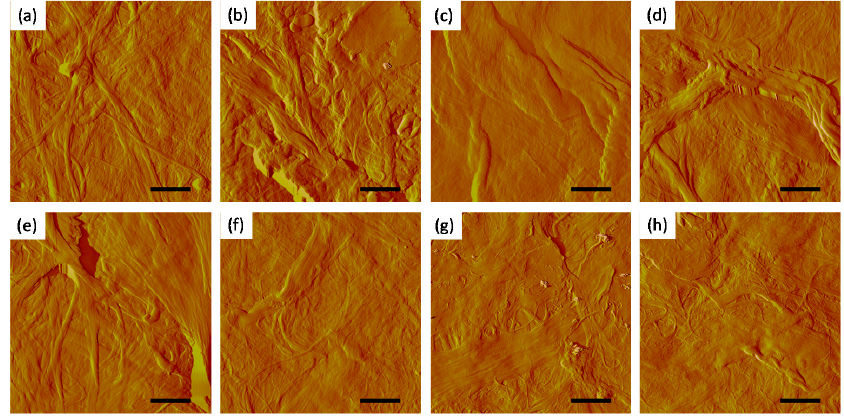
Figure 6. AFM amplitude images (10 × 10 μ m 2 , scale bar = 2 μ m) of sheets from different sources.